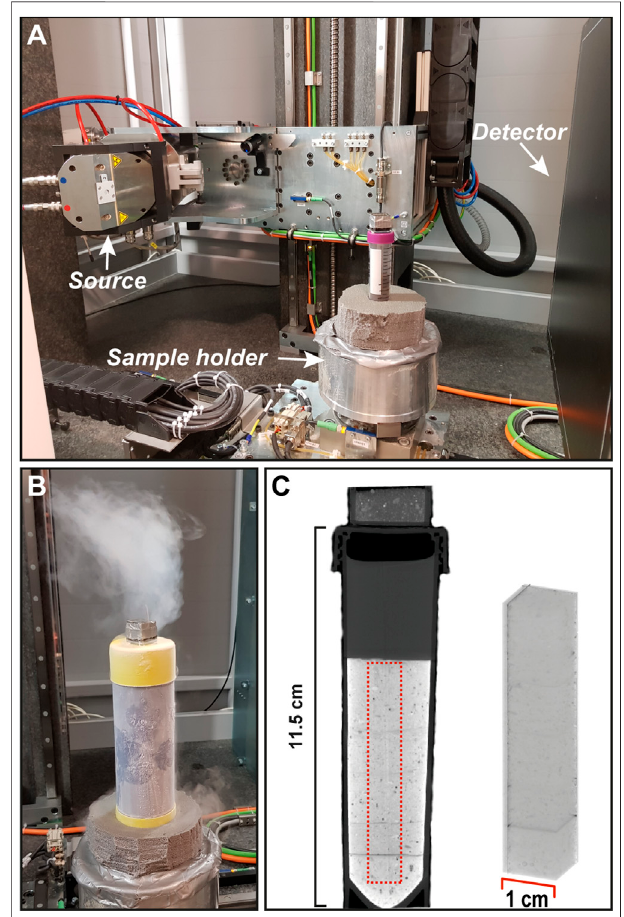
FIGURE 2 | Photographs highlighting key aspects of our experimental setup. (A) The inside of the ProCon CT-ALPHA system we used for scanning, showing the position of the X-ray source (tube) and detector in relation to the sample holder mounted with one of our synthetic cores and calibration standards. (B) Close-upoftheliquid-nitrogen fi lledcasingusedtoscanourice core phantoms. (C) A 2-D CT orthoslice of one of our synthetic cores, highlighting the section used for 3-D reconstruction – visualized on the right side of the panel — in